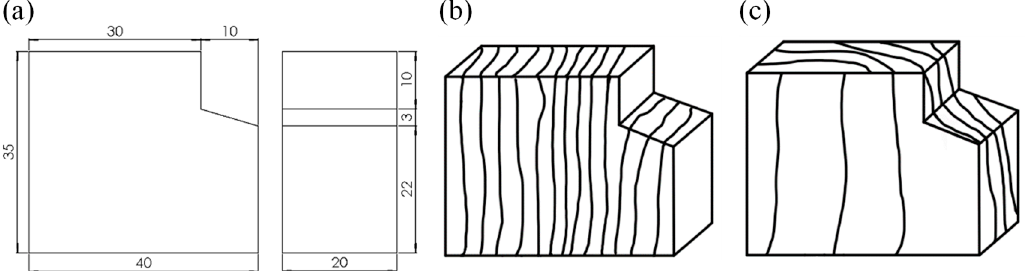
Figure 1. Diagram of shear specimens: ( a ) dimension (in mm); ( b ) tangential shear; and ( c ) radial shear.